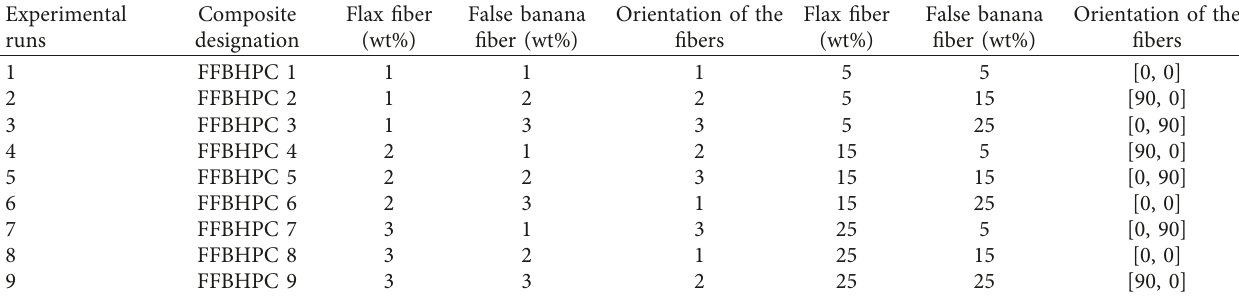
Table 4: Corresponding experimental runs and their composite designation.